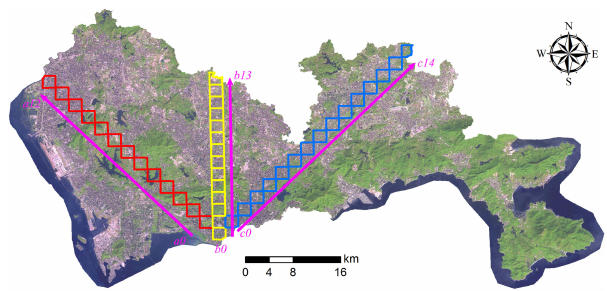
Figure 10. Representative transects.